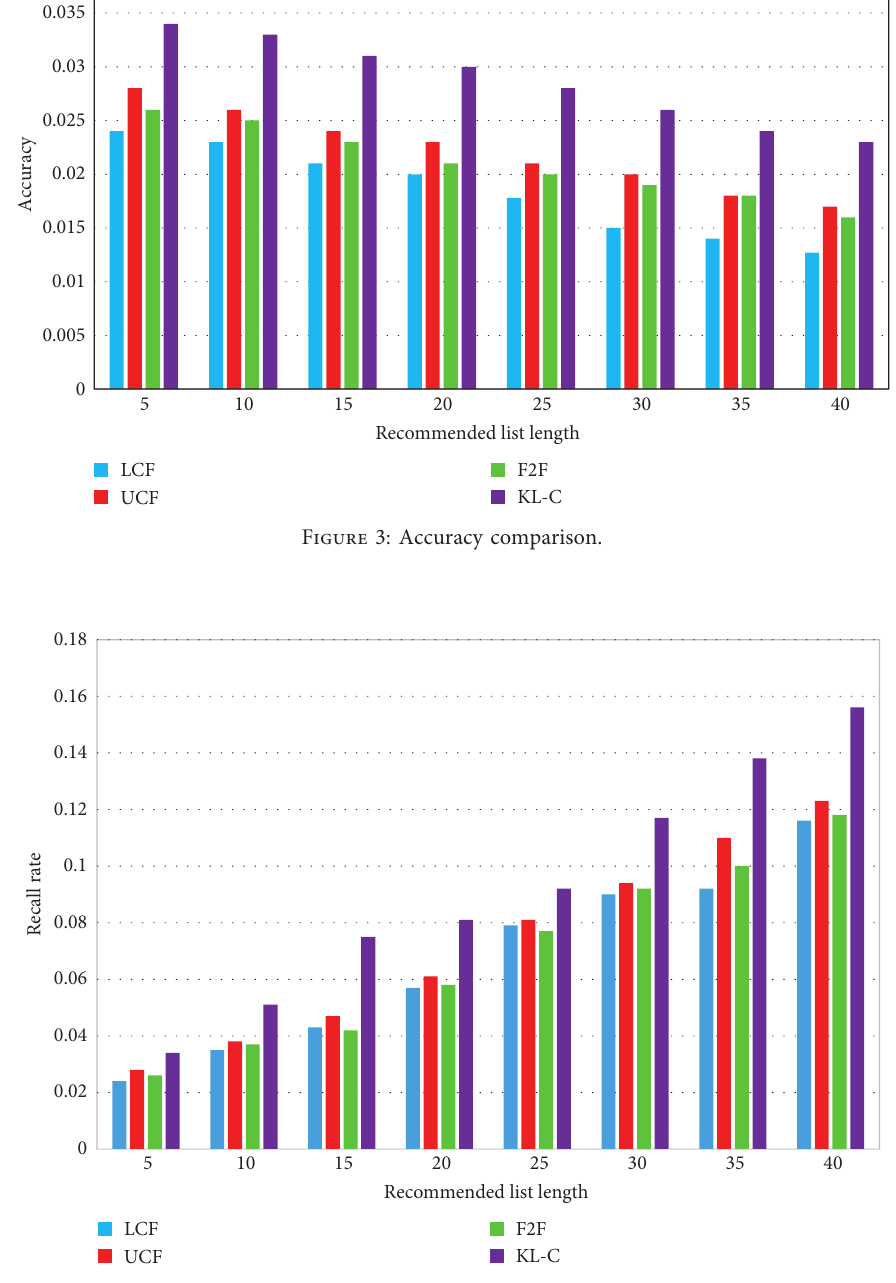
Figure 4: Recall rate